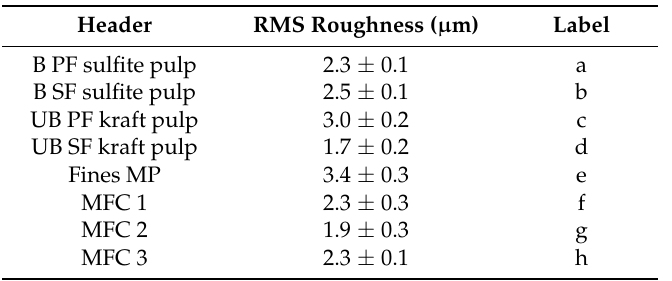
Table 4. RMS roughness of sheets prepared from fines and MFC determined by profilometry and labels used in Figure 6.